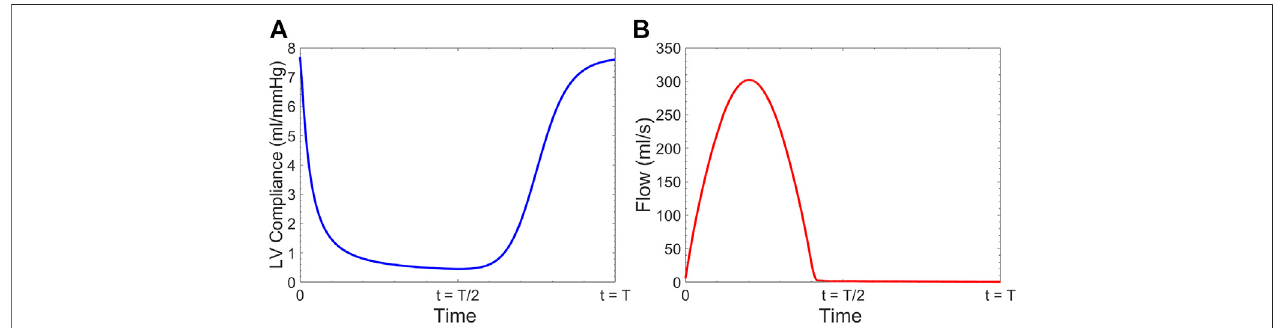
FIGURE 3 | (A) Time-varying left ventricular compliance C v ( t ) , and (B) computed fl ow waveform at the aortic root using our computational